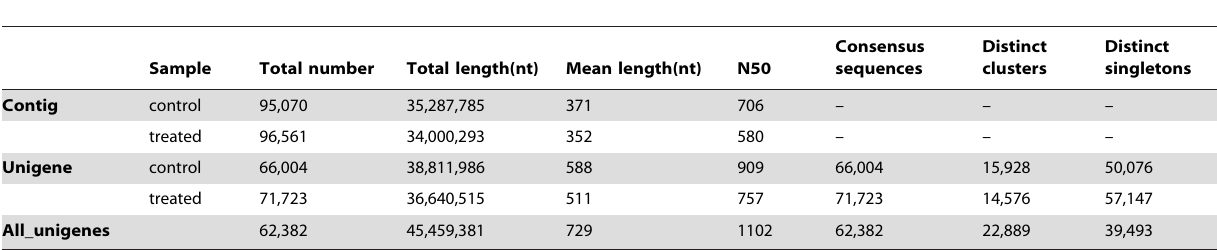
Table 1. Summary for the Illumina sequencing and de novo assembly of O. furnacalis